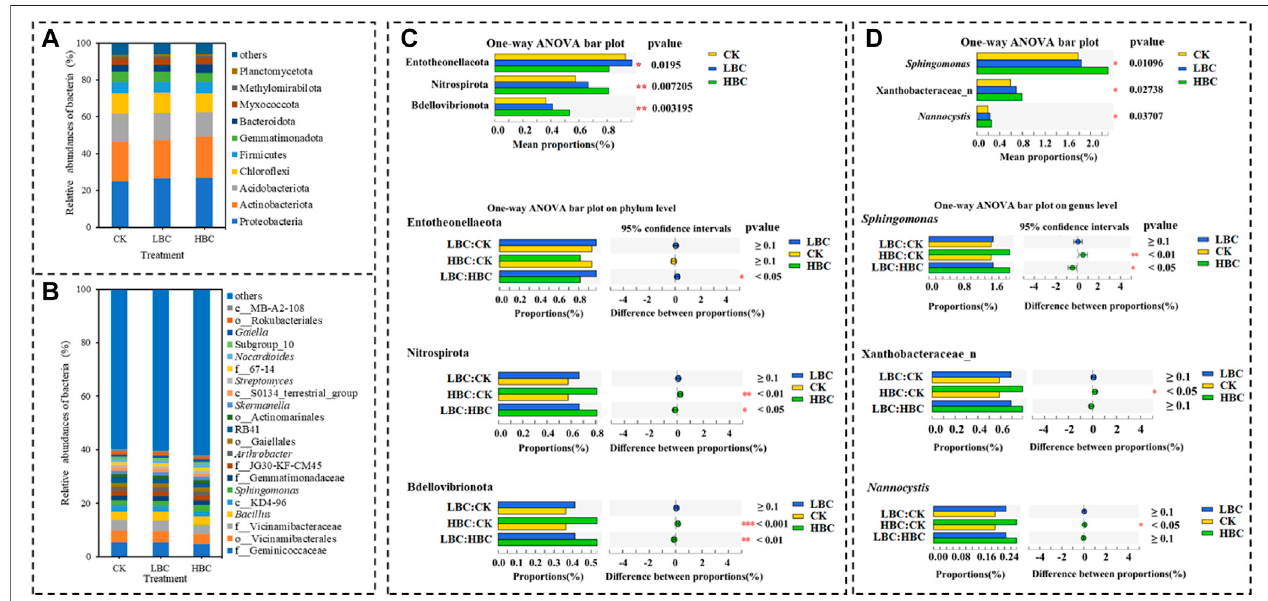
FIGURE 2 | Bacterial community of the coastal saline soil with or without biochar amendment. The relative abundance of bacterial phyla (A) and genera (B) , and differentially abundant bacterial phyla (C) and genera (D) accordingto one-way ANOVA. Othersrefertobacteriaand fungi with arelative abundancelower than 1%. The signi fi cances (n = 6) are marked with asterisks (*0.01 ≤ p < 0.05, **0.001 ≤ p < 0.01, *** p < 0.001). CK, soil without biochar amendment; LBC, soil amended with a low amount of biochar at 18 t/ha; HBC, soil amended with a high amount of biochar at 36